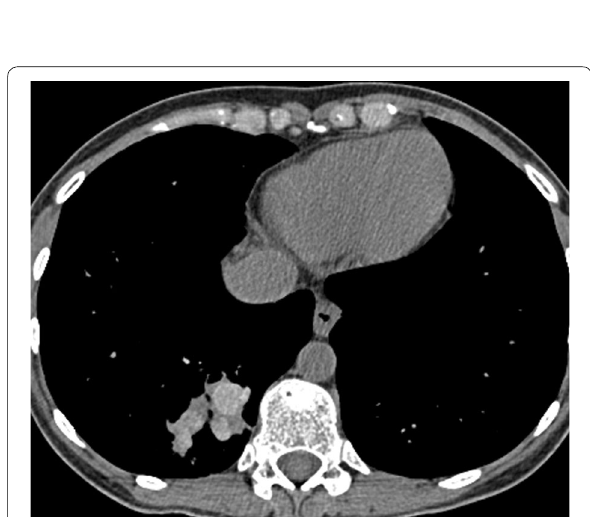
Fig. 2 Hyper-attenuated mucous obstructing distal segments of the right lower lobe in ABPA. Woman with asthma who developed ABPA after exposure to a mouldy house (new renovation that leaked). During pregnancy starting coughing black plugs up and had an episode of ‘pneumonia’. CT scan shows rounded opacities posteriorly in the right lung base which are enlarged bronchi full of mucus. On the lung windows, rounded shadows are typical of mucus in bronchi, with some surrounding inflammatory change, on the bone windows (shown here), the mucus in some places appears white than others, consistent with hyper-attenuated mucous